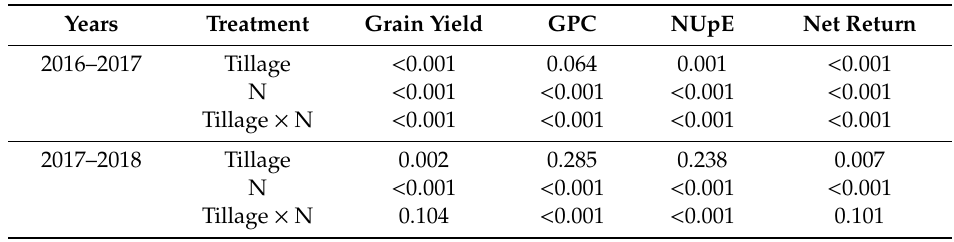
Table 3. ANOVA results ( p -values) of the e ff ects of tillage methods and N management strategies on grain yield, GPC, NUpE, and net return.